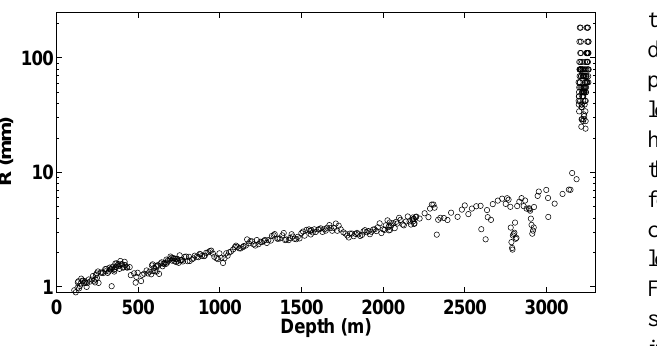
Figure 6. Mean equivalent crystals radii in the basal ice layers of the EPICA Dome C ice core, as compared to measurements in ice above 3200m depth from Durand et al. (2007). Basal ice measurements are preliminary results obtained using the linear intercept technique “on site”, while the data from above 3200m were obtained using automatic ice texture analyzers (AITAs – Wang and Azuma, 1999; Russell-Head and Wilson, 2001; Wilen et al.,